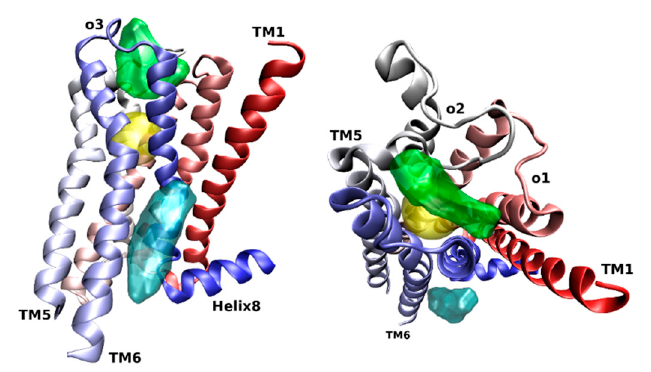
Figure 2. Side view with TM6 front (left), and extracellular view (right) of the orthosteric (yellow), common allosteric (green), and cholesterol (cyan) binding sites at the M 2 receptor (4MQT) (colored in red-white-blue gradient).